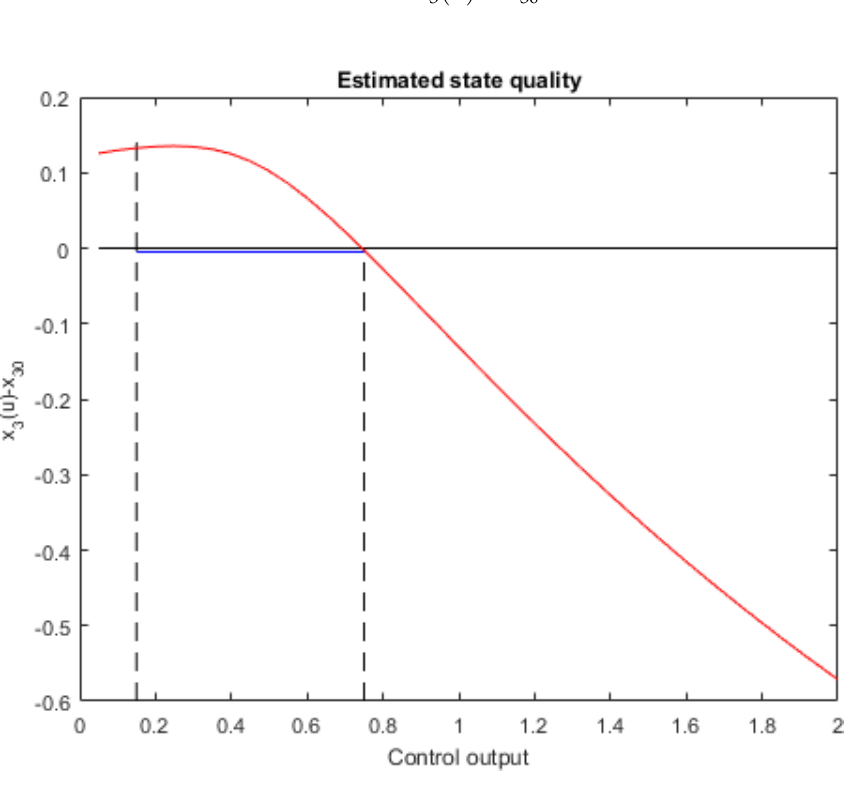
Figure 1. ESTIMATOR—quality criterion for PRP.